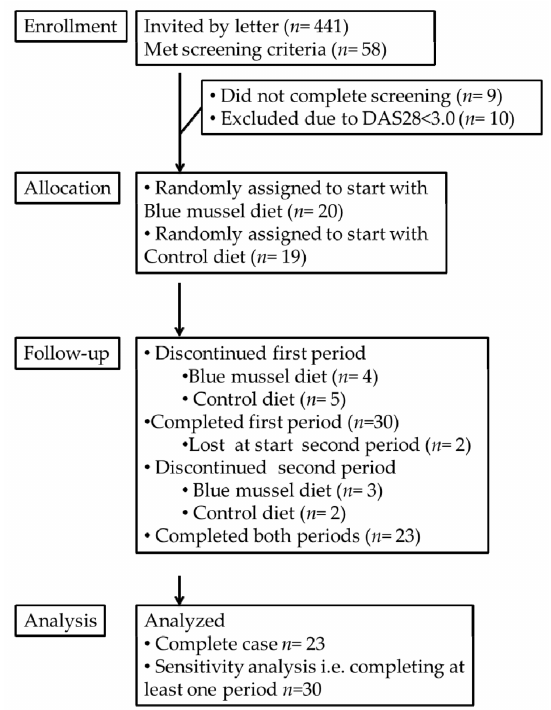
Figure 1. Consolidated standard reporting trial diagram of Mussels, Inflammation and Rheumatoid Arthritis